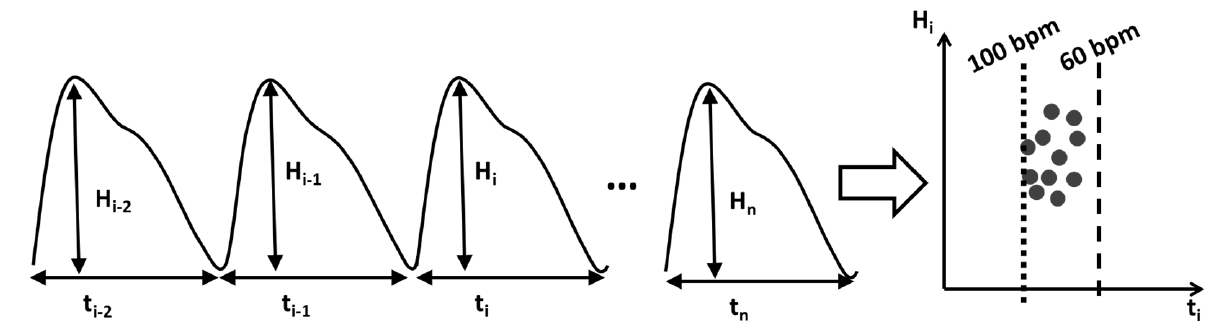
Figure 3. Illustration of the transformation of PPG signals to flux-interval plot with H i vs. t i . On each sample set of ( t i − 1 , H i ) and ( t i , H i ), DBSCAN (Density-based spatial clustering of applications with noise) clustering was applied. Conceptually the clustering result would reflect the types of pulses within the signal based on each pulse’s location flux-interval plot. The orthogonal regression was then applied to the main cluster (the cluster with the most data) of ( t i , H i ) sets, and the residual errors were recorded in the form of root-mean-squared error (RMSE). As the examples show in Figure 4, we expected that the fitted regression line of the main cluster would result in a smaller RMSE on premature contractions as they tend to have tight clusters as opposed to the more scattered distribution of AFib on the flux-interval plot. We intend to use this denoted “Regression RMSE of Main Cluster” as a simple index to represent the degree of dispersion of each sample.